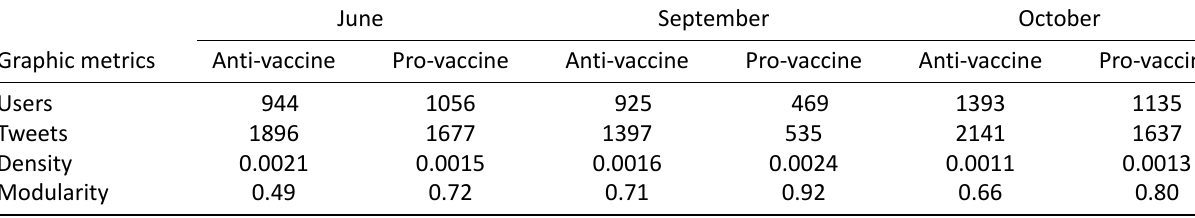
Table 1. Number of users and tweets forming the anti- and pro-vaccine